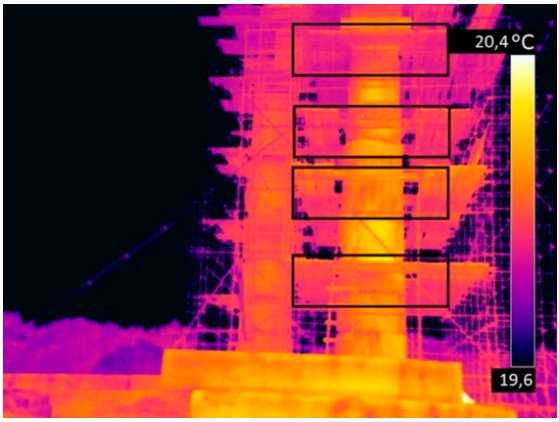
Figure 32. Anisotropic thermal distribution.